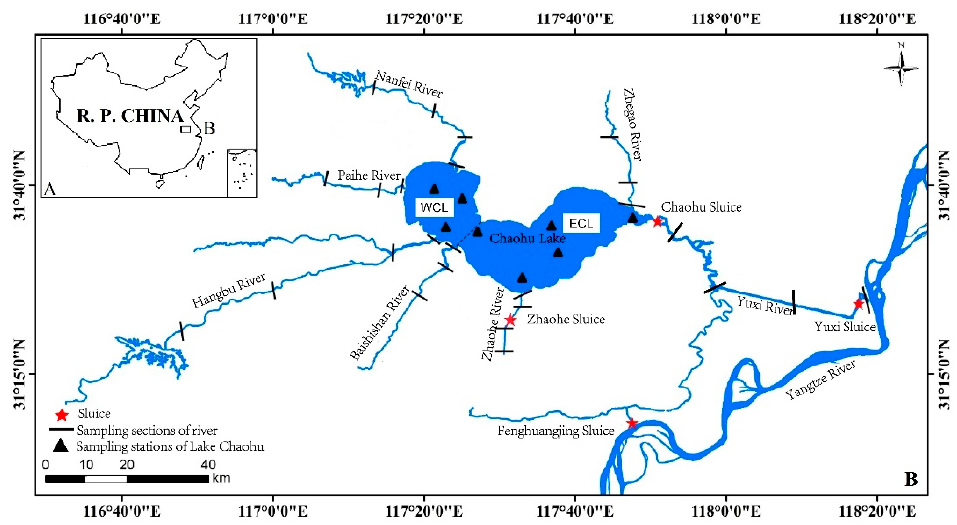
Figure 1. Distribution of sampling sites in the Chaohu Lake Basin.